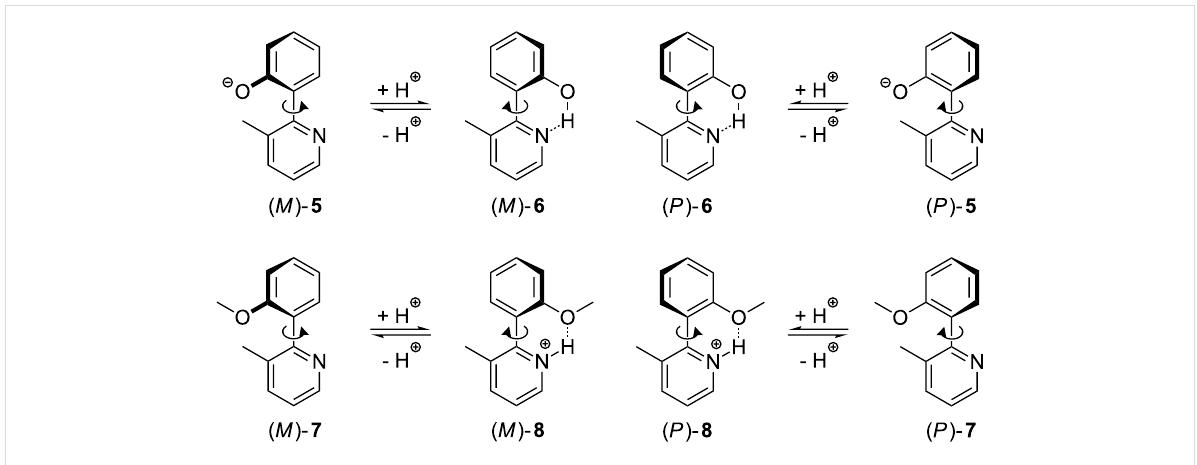
Scheme 2: Principle of the switching mechanism of 2-(2-hydroxyphenyl)-3-methylpyridine ( 6 ) and 2-(2-methoxyphenyl)-3-methylpyridine ( 7 ).